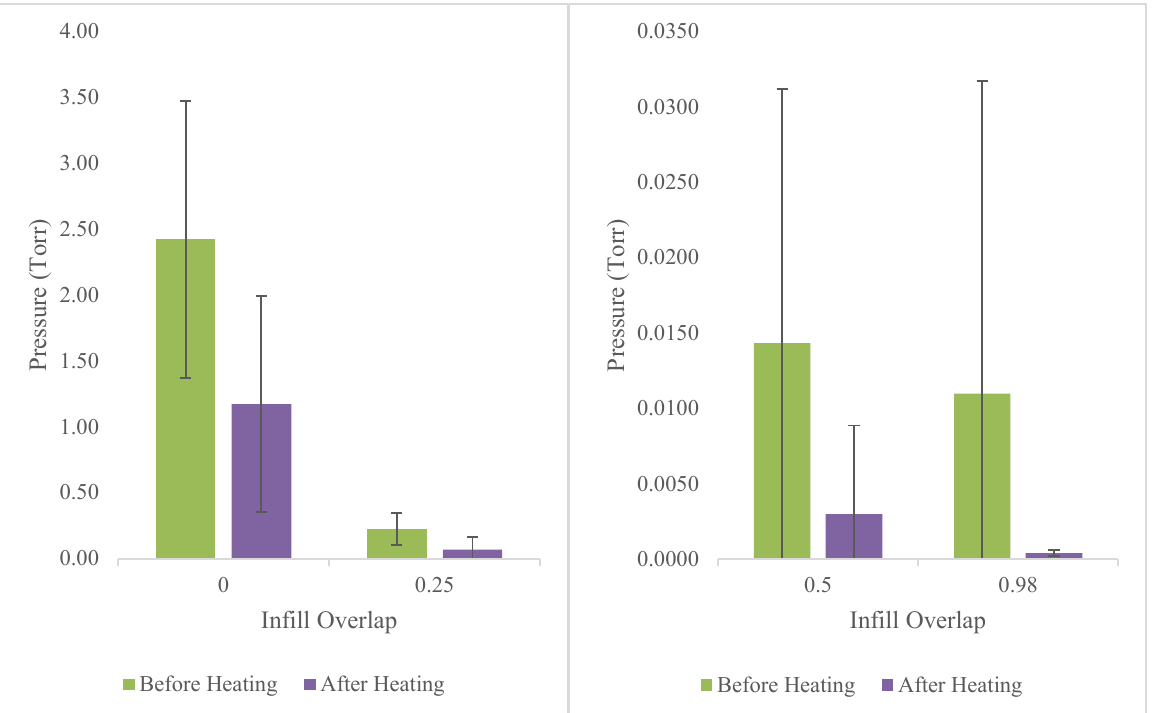
Figure 8. Final pressure reached for each infill overlap percentage before and after heating with 95% confidence intervals. Right graph has excluded 0% and 25% infill overlaps for ease of reading .